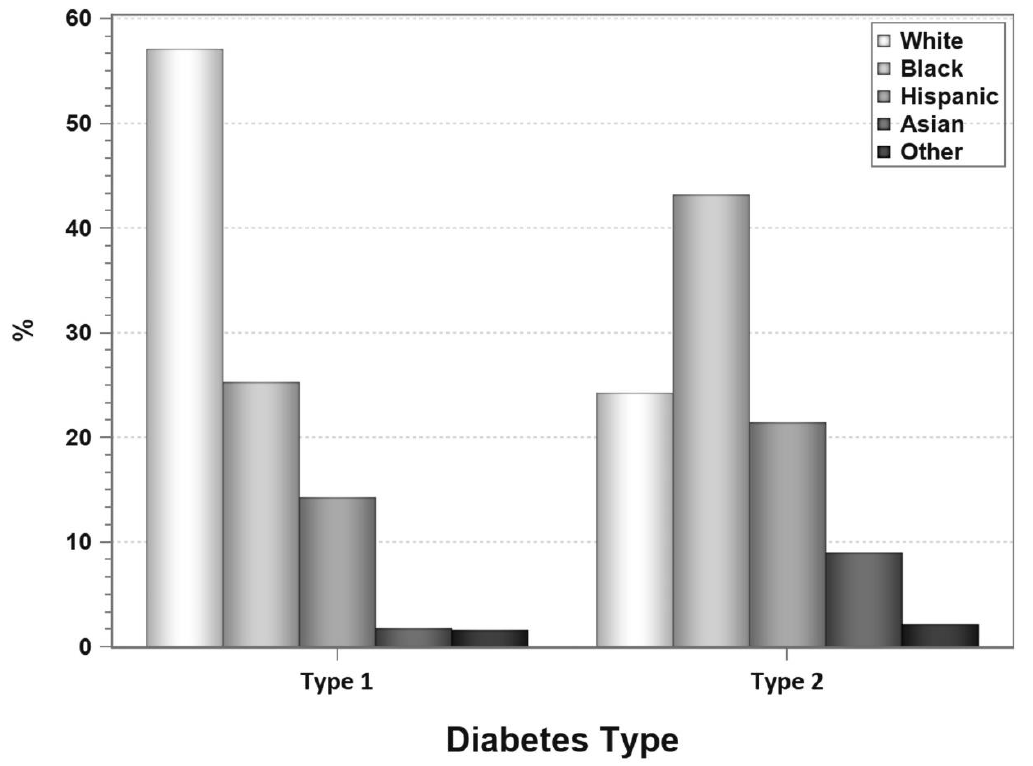
Figure 3. Number of minority recipients by PTx category in 5-year increments for US cases as reported to the IPTR.